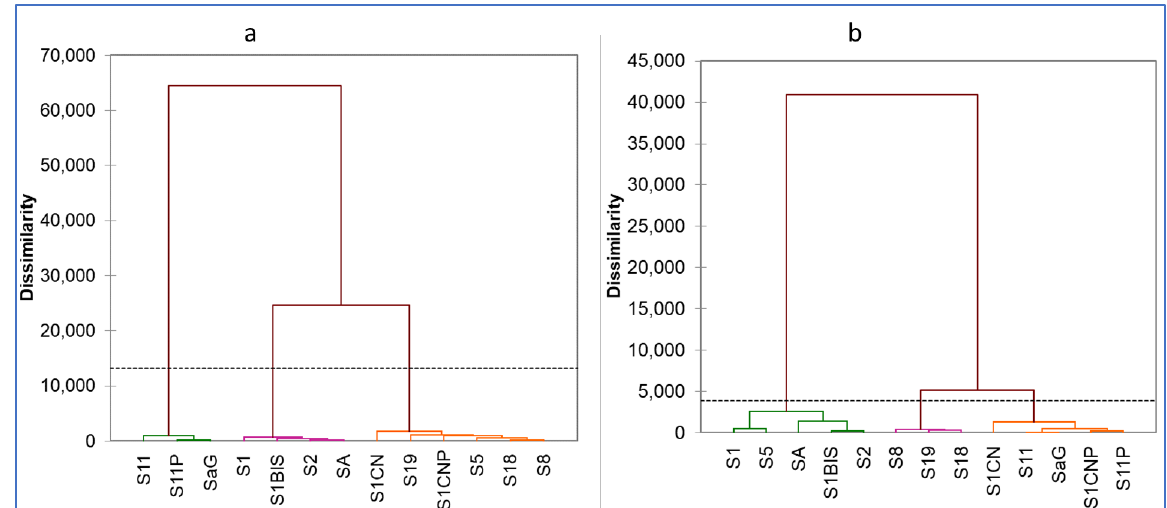
Figure 10. Dendrogram of individuals: ( a ) low water and ( b ) high water. During low-water periods, the PCA presenting the correlation between the chemical parameters of the aquifer water allowed retaining the two main axes since they presented more than 59.35% of the total variance (Figure 11a). The F1 axis which presents 32.63% of this variance is strongly correlated on the positive side with EC (0.73), Ca 2+ (0.85), and Cl − (0.74) and negatively correlated with Mg 2+ ( − 0.705), K + ( − 0.41), and NO 3 − ( − 0.41) (Table S3 in Supplementary Materials). This set of variables associated with F1 suggests that salini-